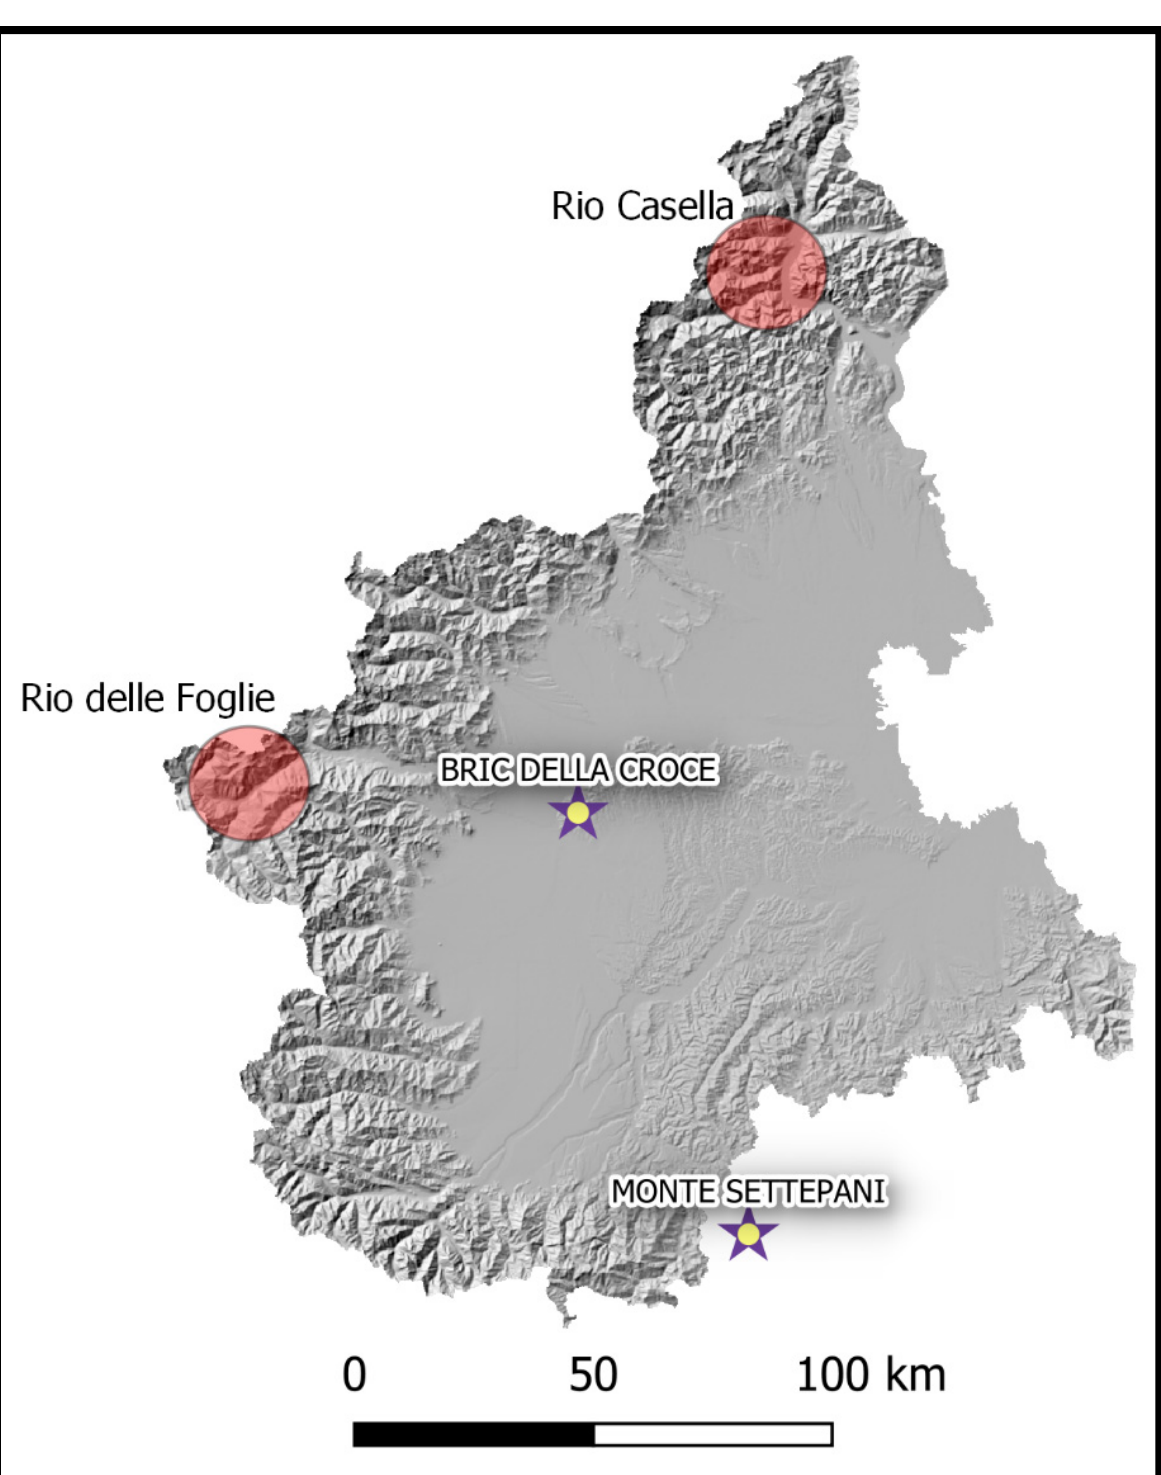
Figure 7. Weather radars’ location (star symbols) and the location of the two catchments (red circles). The second C-band weather radar is located on the top of Monte Settepani peak at 1386 m asl, near Savona, in the Ligurian Apennines. Monte Settepani radar has an excellent visibility in the north and east sectors, corresponding to the Po valley and the mountain areas of Piemonte. Monte Settepani radar performs a volume scan every ten minutes. The volume scan is polarimetric and the acquired parameters are the same as for the Bric